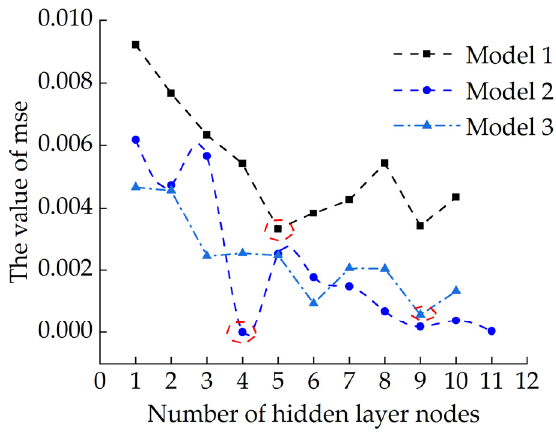
Figure 29. The relationship between the MSE value and the number of hidden nodes.